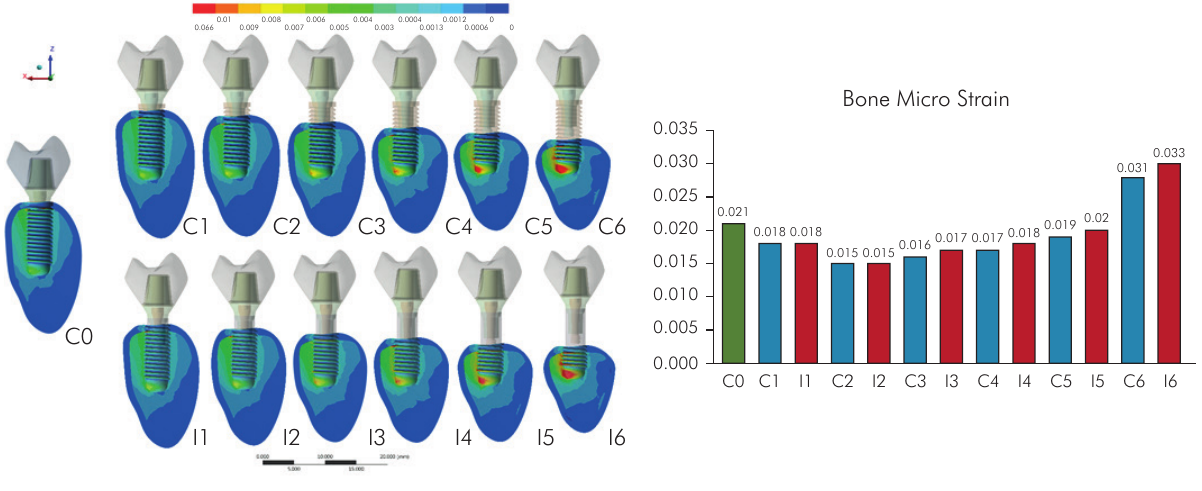
Figure 5. Micro strain on the bone tissue for all